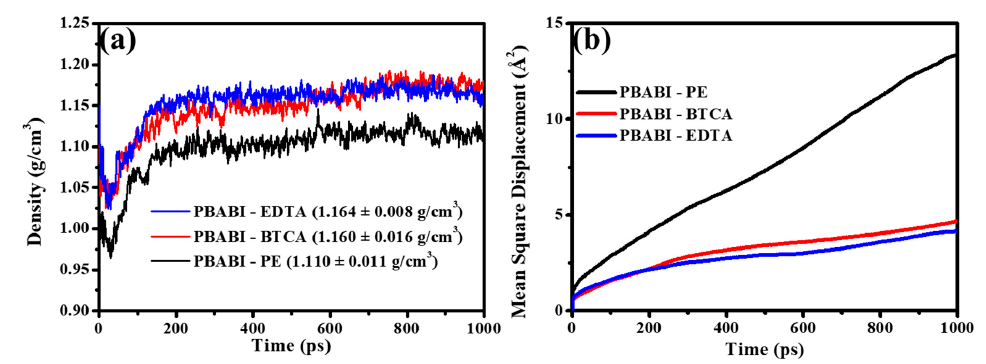
Figure 11. ( a ) Density and ( b ) mean square displacement profiles as a function of simulation time for PBABI copolyester with different modifiers of PE, BTCA, and EDTA.